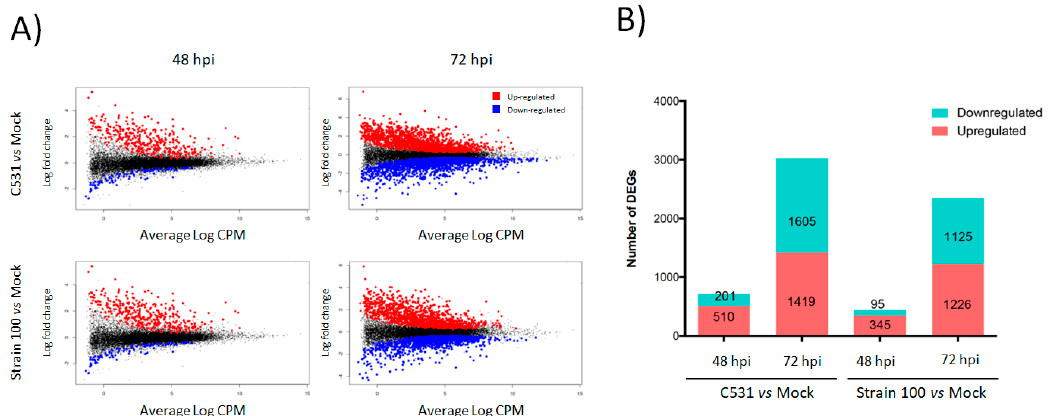
Figure 2. Global overview of the P. vulgaris transcriptomic response to inoculation with C. lindemuthianum under compatible (Strain 100) and incompatible interaction (C531). ( A ) LogCPM expression vs. Log2 fold change plots (MA-plots) were calculated for inoculated vs. Mock condition at each time point. Significant DEGs with adjusted p -value < 0.05 are plotted in red (Up-regulated) and blue (Down-regulated). ( B ) Numbers of significant DEGs in inoculated plants vs. Mock condition at each time point.